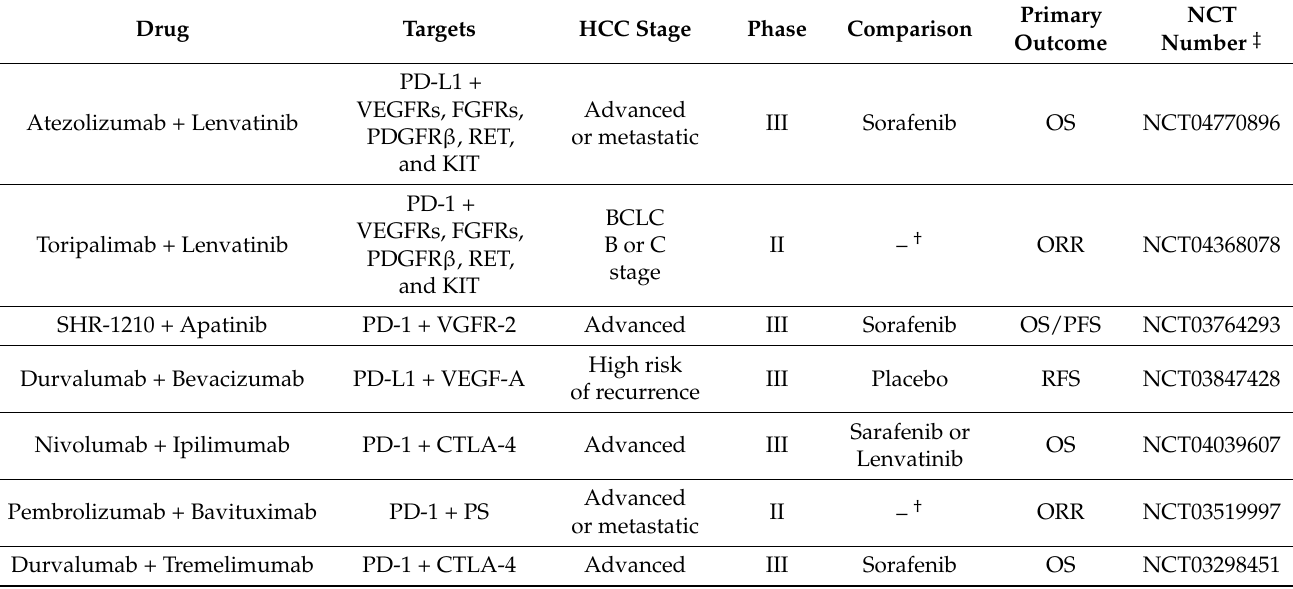
Table 2. Combination of immune checkpoint inhibitor therapies in clinical